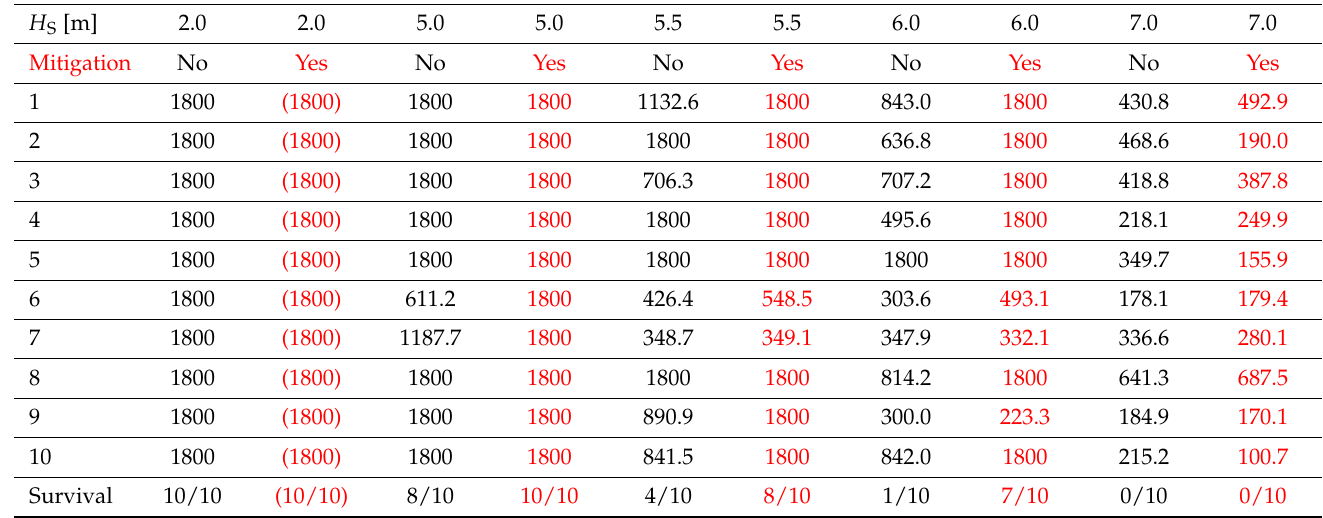
Table 3. Damage Case 4, with (red) and without (black) recovering the lost buoyancy in compartment T045, in beam seas. The values in brackets were not explicitly computed, as the result (survival) is